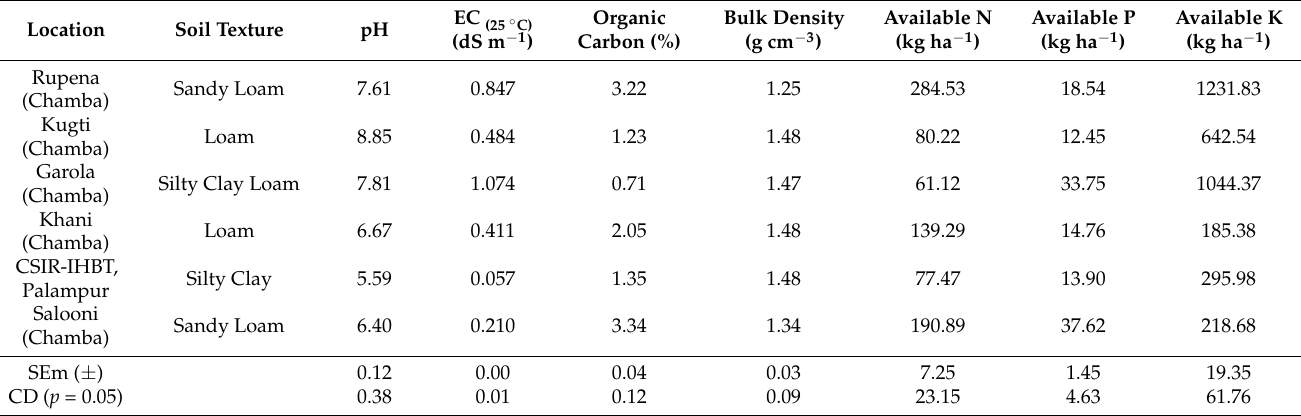
Table 2. Physico-chemical properties of soil of different locations of sample